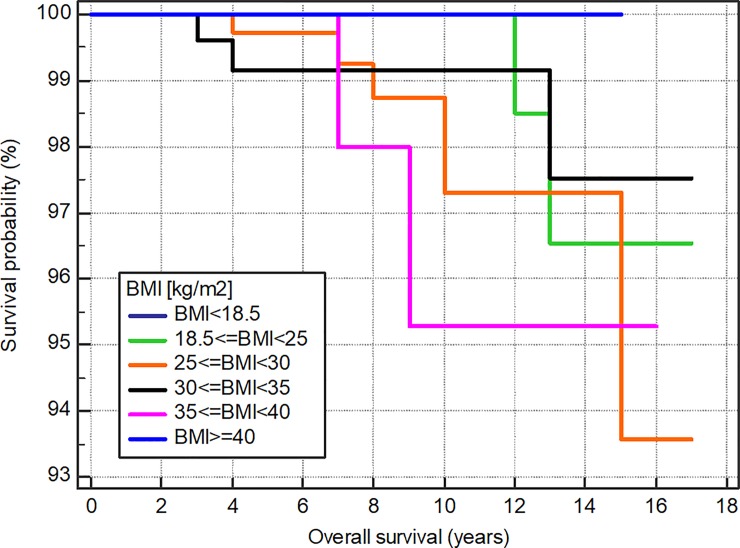
Comparison of overall survival according to BMI group.No significant differences were detected among individuals in the underweight (BMI < 18.5), normal body weight (18.5 ≤ BMI < 25), overweight (25 ≤ BMI < 30), grade 1 obese (30 ≤ BMI < 35), grade 2 obese (35 ≤ BMI < 40), or grade 3 obese (BMI ≥ 40) groups (p = 0.7723).